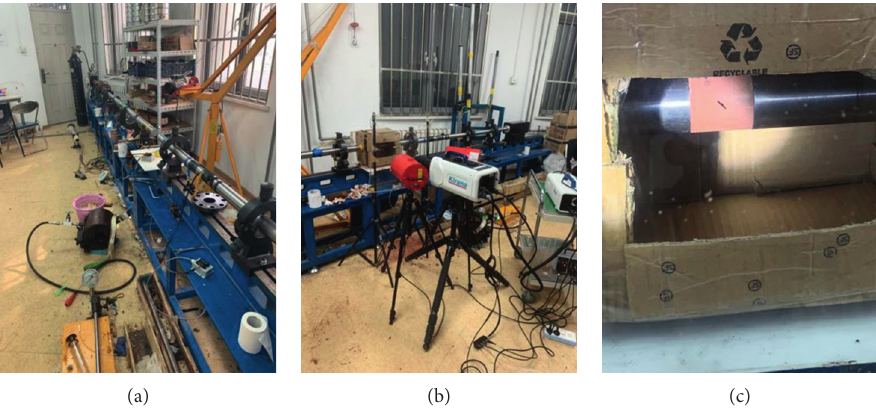
Figure 3: SHPB experiment rig and high-speed photography